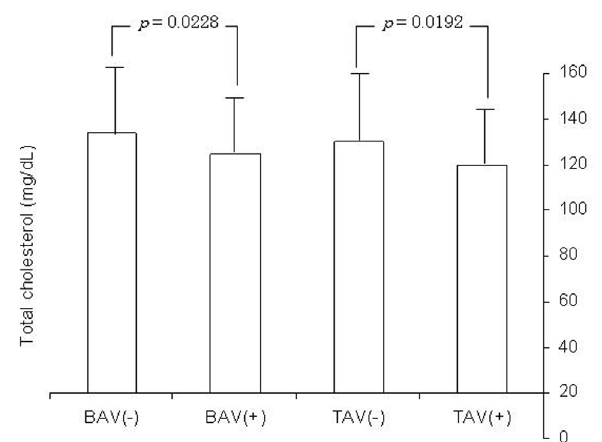
Figure 4 - Intra-group differences between patients receiving statin therapy and those not receiving statin therapy. (+) = receiving statin therapy; (-) = not receiving statin therapy; BAV = bicuspid aortic valve; TAV = tricuspid aortic valve.